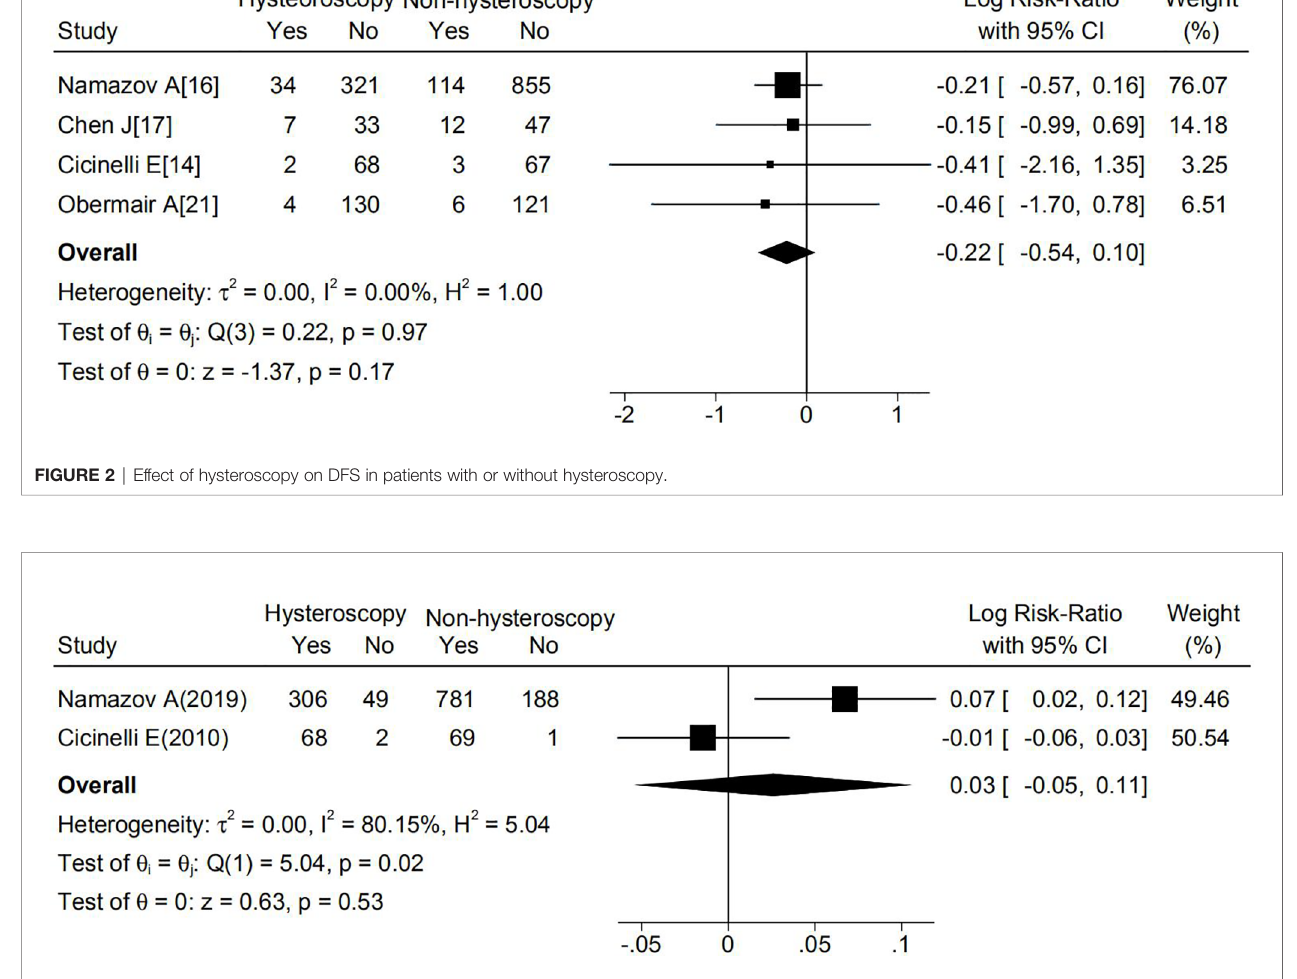
FIGURE 3 | Effect of hysteroscopy on OS in patients with or without hysteroscopy.